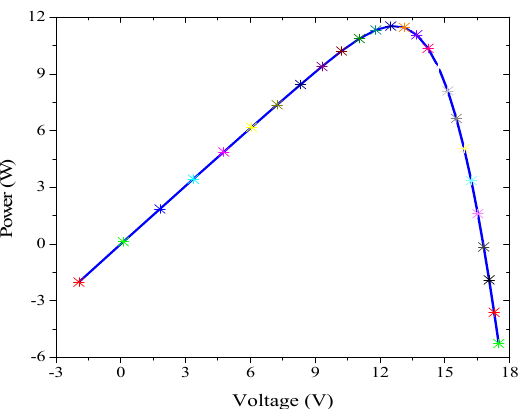
Figure 14. P–V curve obtained from the calculated current for the double-diode module. Table 12. I–V values and the relative IAE for the double-diode module. Sr. Number